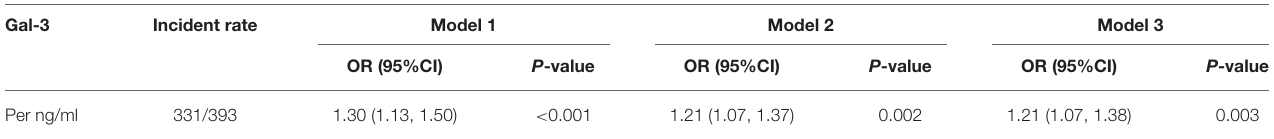
TABLE 2 | Association between serum Gal-3 and presence of CAD.